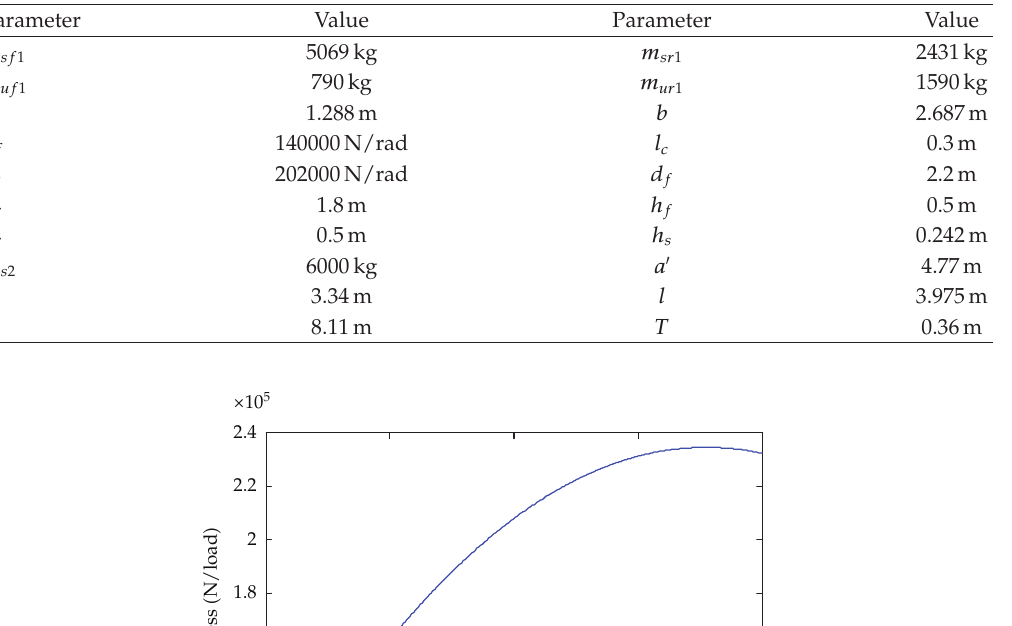
Table 2: Characteristics of the tractor semi-trailer with two rear axles.